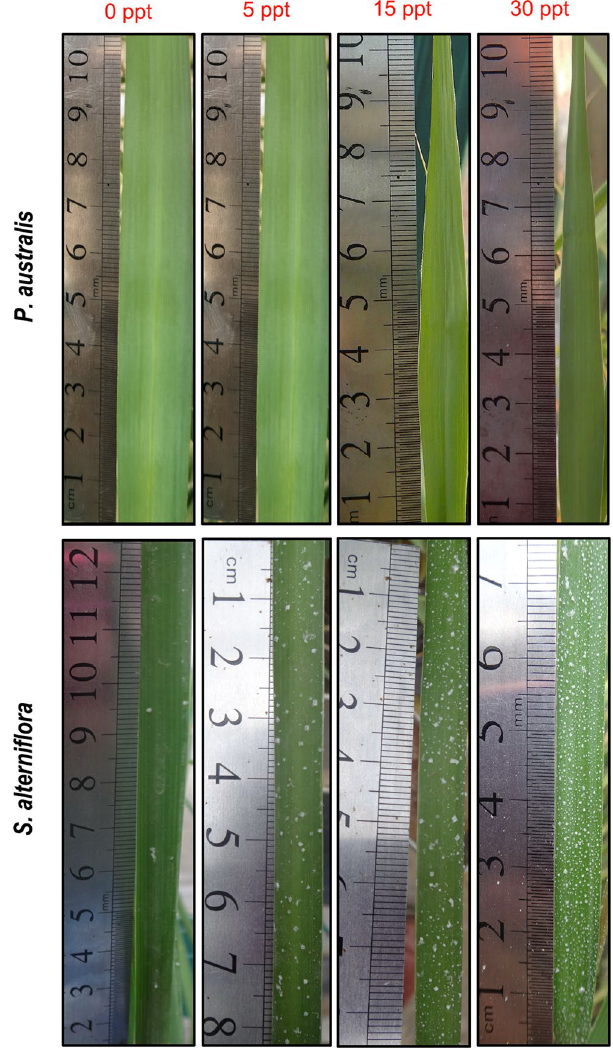
Figure 6. Leaves of P. australis (upper panel, no salt secretion) and S. alterniflora (bottom panel, distinct salt secretion) subjected to the salinity gradient. The amount of salt secretion was similar between waterlogging treatments. (Photos by S.H.L. and